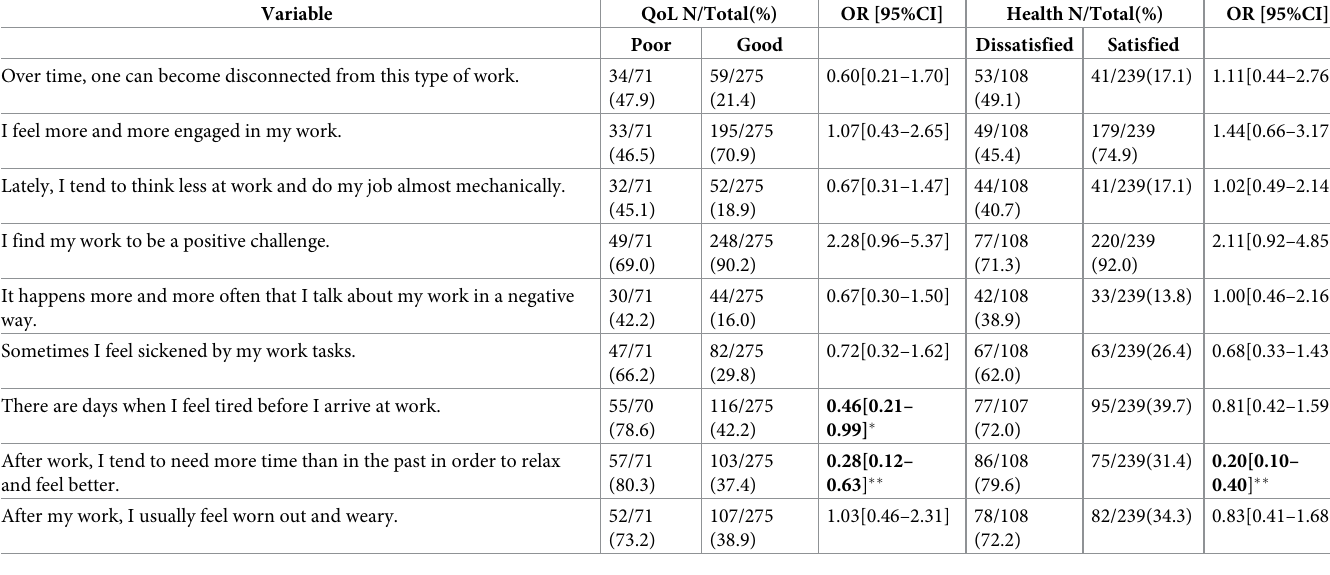
Table 4. Binary logistic regression analysis between occupational burnout and the two general questions on quality of life (n = 347).